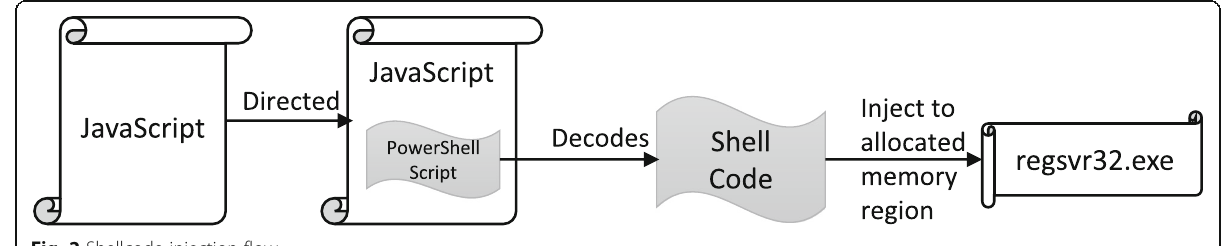
Fig. 2 Shellcode injection